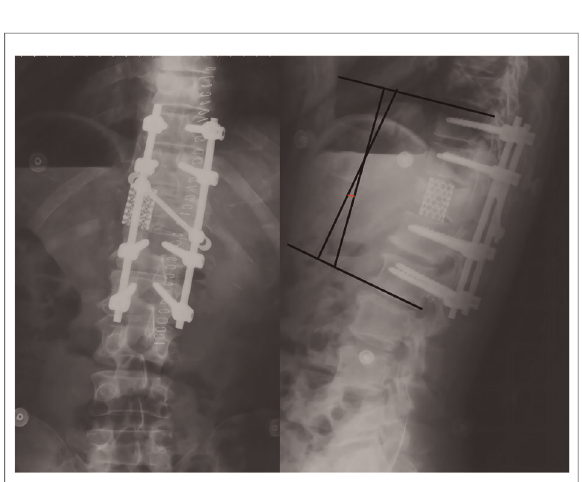
FIGURE 6 Anteroposterior and lateral radiographs of the thoracolumbar segment; Thoracolumbar cobb angle is 11° (One week after surgery).